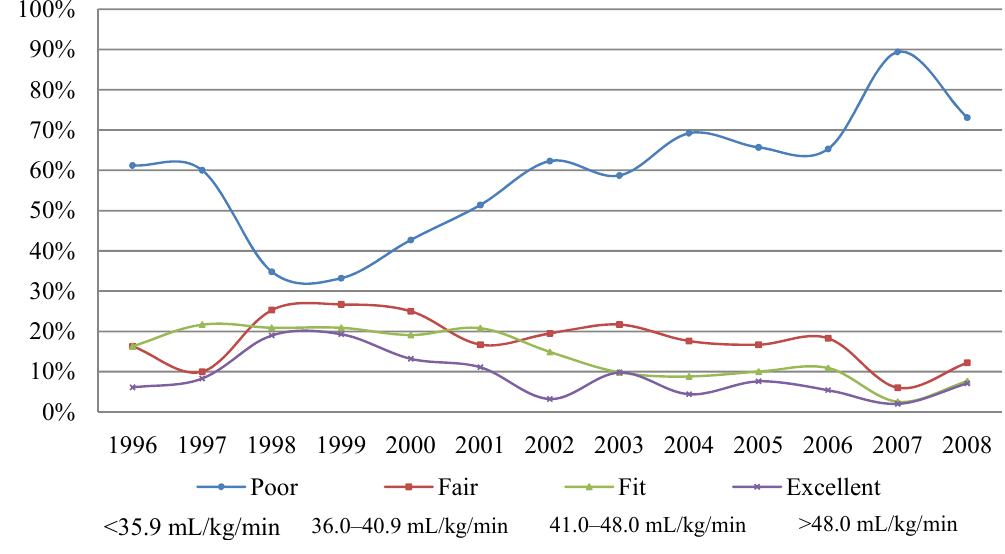
Figure 3. Percentage of males falling into the four difference fitness categories